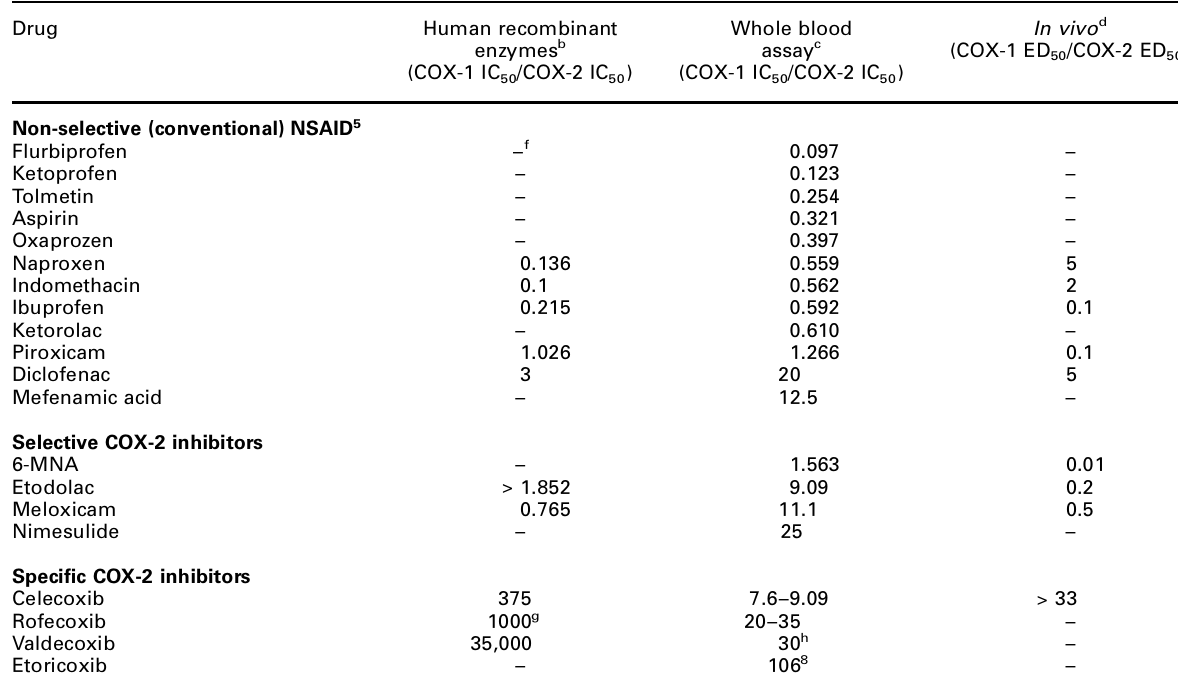
Table 1. COX-1/COX-2 ratios a for selected NSAIDS by various assays Drug Human recombinant